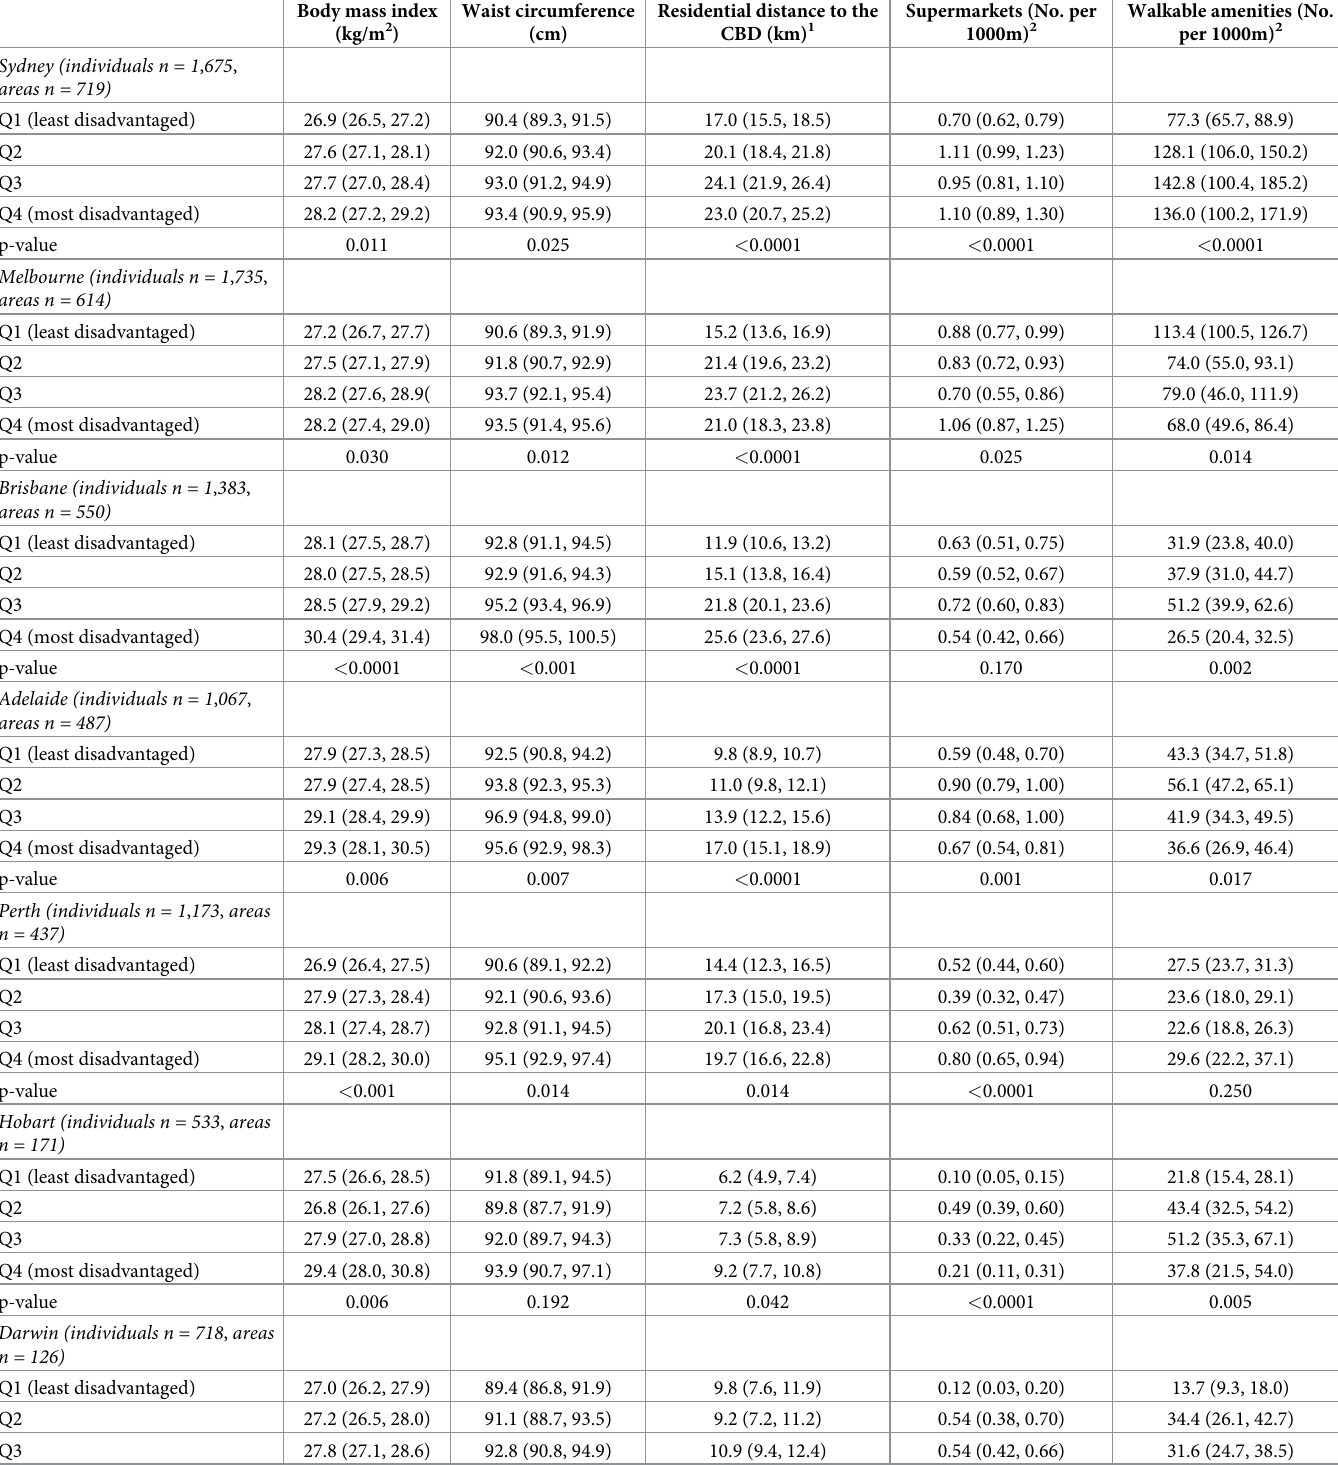
Table 2. Body mass index (kg/m 2 ), waist circumference (cm), residential distance to the CBD, supermarket count, and walkable amenities, by neighbourhood disad- vantage and capital city (bivariate associations using